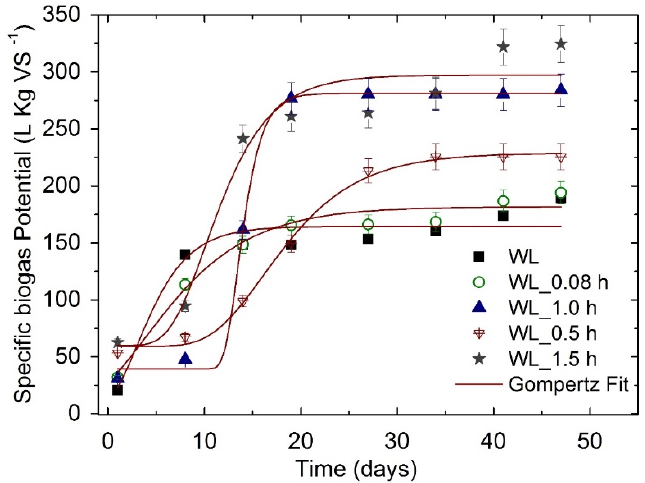
Figure 4. Cumulative specific biogas potential of AD tests after electro-oxidation pre-treatments.